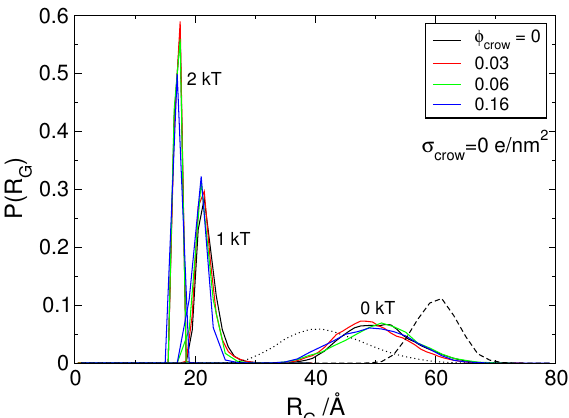
Figure 3. Probability distribution of the radius of gyration, P ( R G ) , of the polyion in the presence of model protein dimers with different attractive potential (0, 1 and 2 kT as indicated), for an increasing number of crowding particles with σ crow = 0 e /nm 2 . The dashed line corresponds to the model DNA calculated in the presence of its counterions only and the dotted curve to the size distribution of a neutral polymer with the same number of monomers,